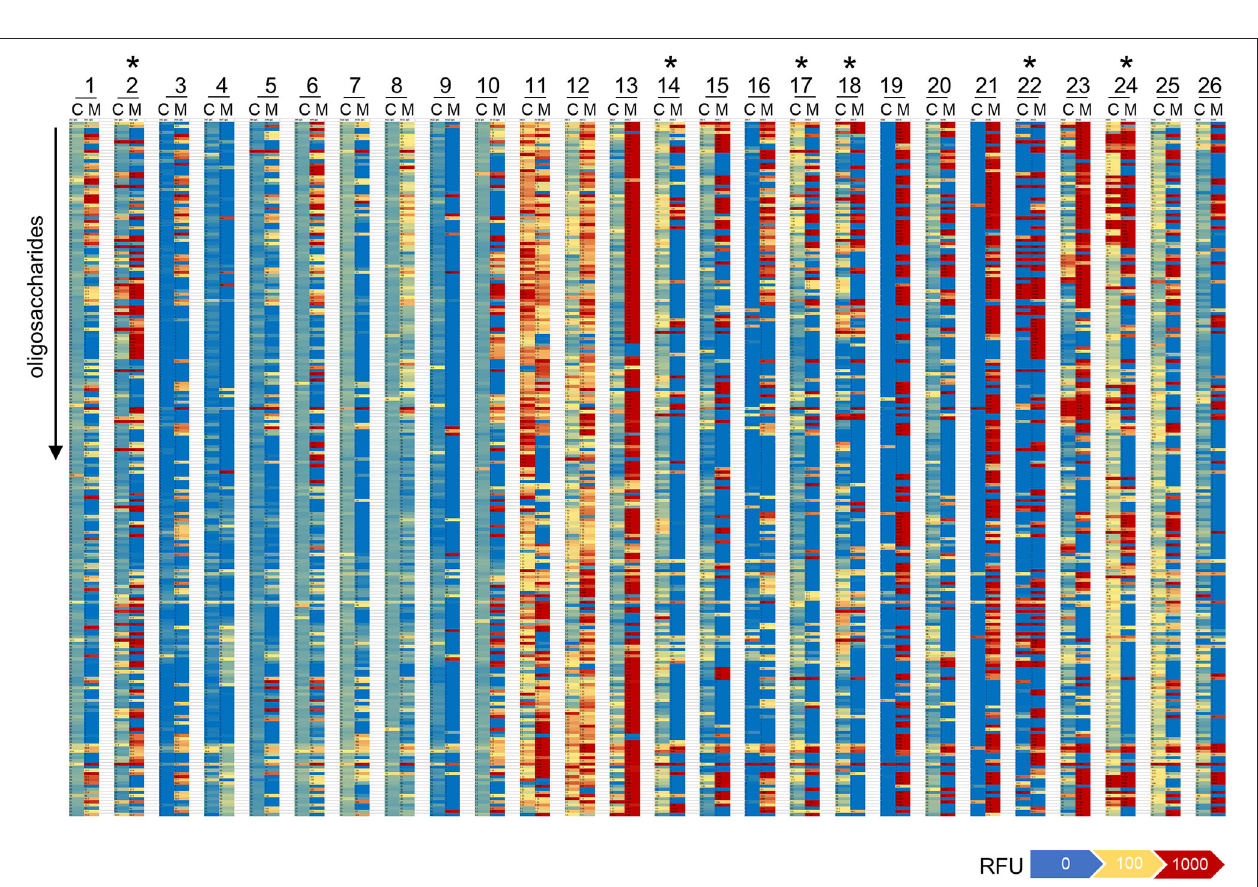
FIGURE 3 | subgroups of sialylated glycans (mono-sialylated, S1; di-sialylated, S2). (D,E) IgG reactivities of CB and MB samples to glycan structures S1 and S2. A subgroup of samples with comparable maternal IgG reactivity is marked in red. The composition of glycans is indicated by the number of different monosaccharides